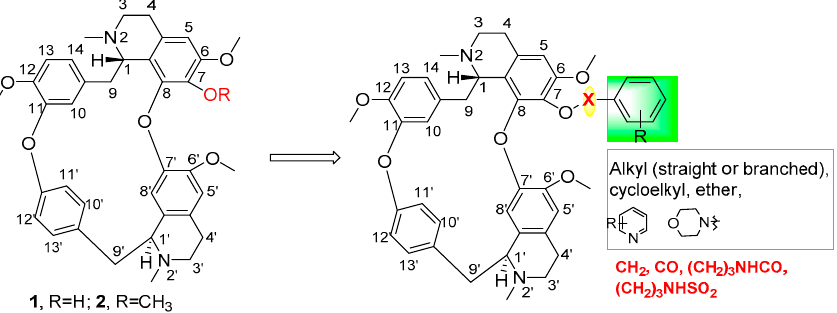
Figure 1. Chemical structures of fangchinoline ( 1 ), tetrandrine ( 2 ) and the modification